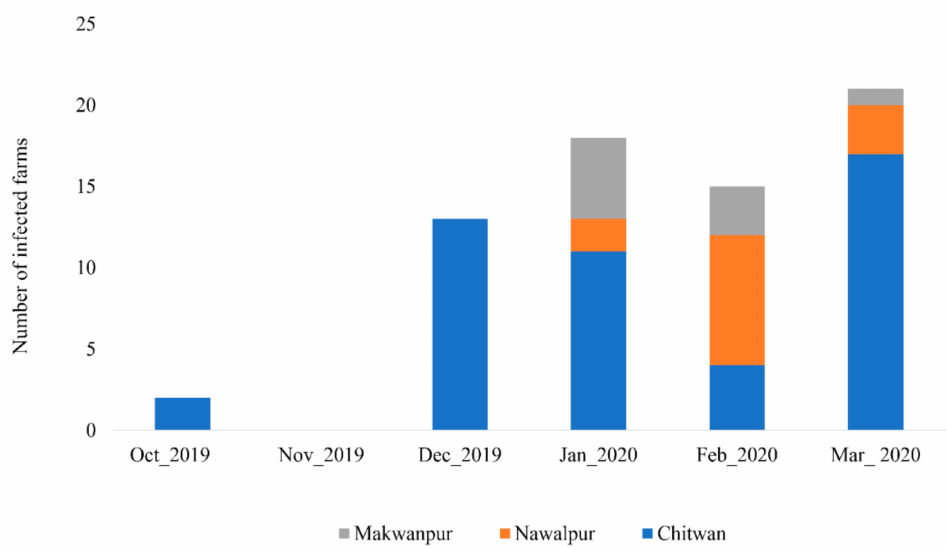
Figure 2. Epidemic curve of avian influenza subtype H9 outbreaks in poultry farms of central lowland Nepal.